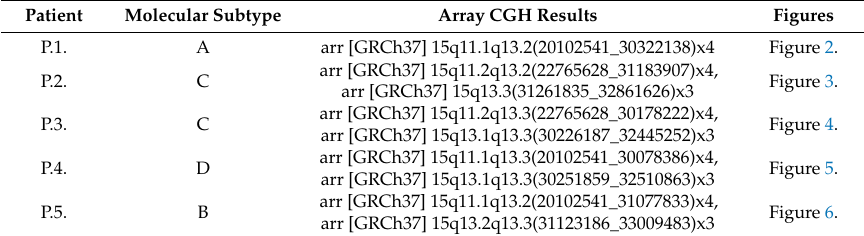
Table 1. Molecular subtype and array CGH results of the idic(15) chromosomes.